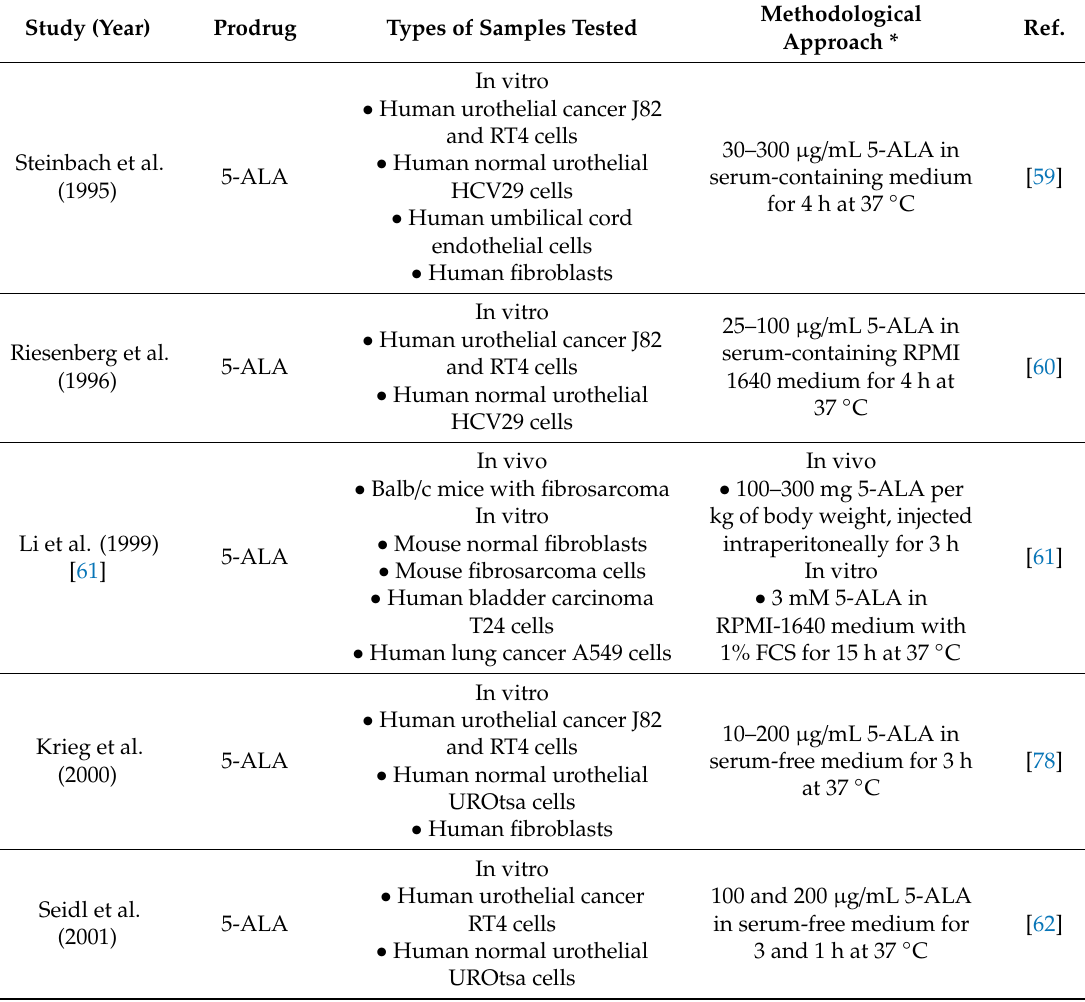
Table 3. Studies of prodrug application in cell lines or in